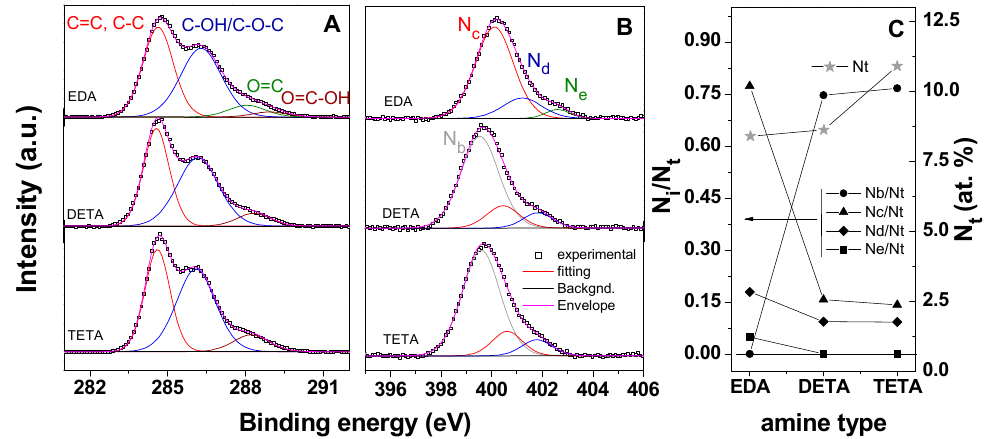
Figure 6. XPS C 1s spectra ( A ), N 1s ( B ) and N configuration contribution (N i / N t ) and total N content (N t , at%) for modified cryogels with amine type ( C ).